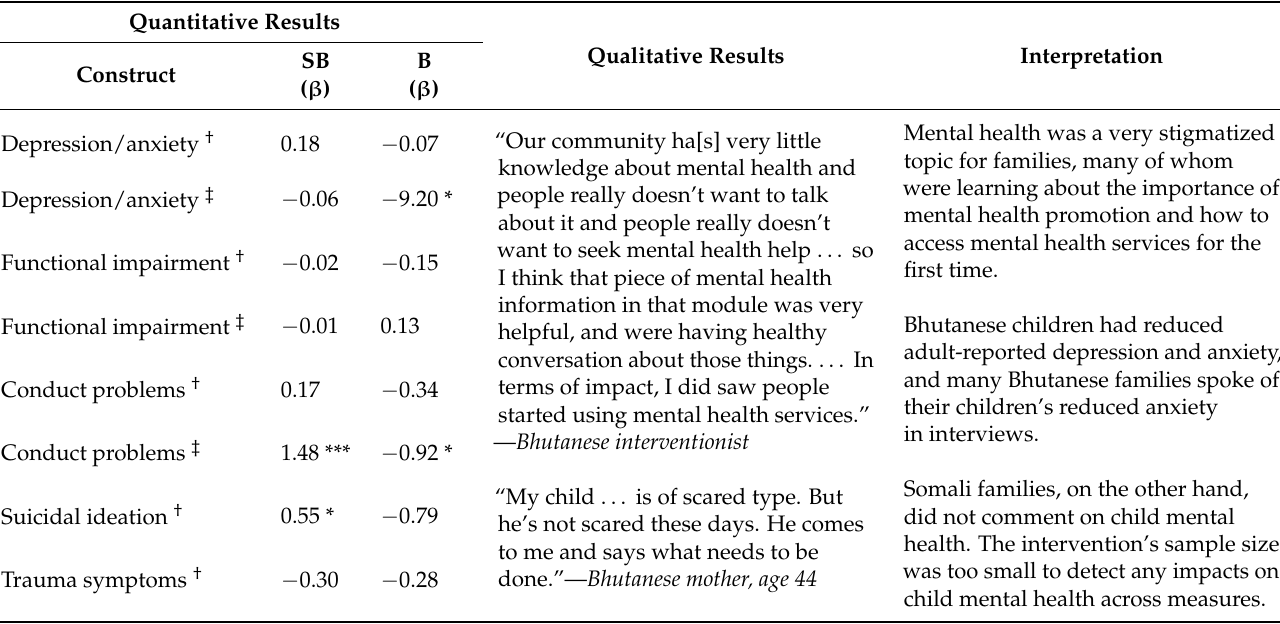
Table 3. Joint display table: Integration of quantitative (point estimates comparing pre- to post-test change of the intervention versus CAU participants) and qualitative (interview data) about child mental health